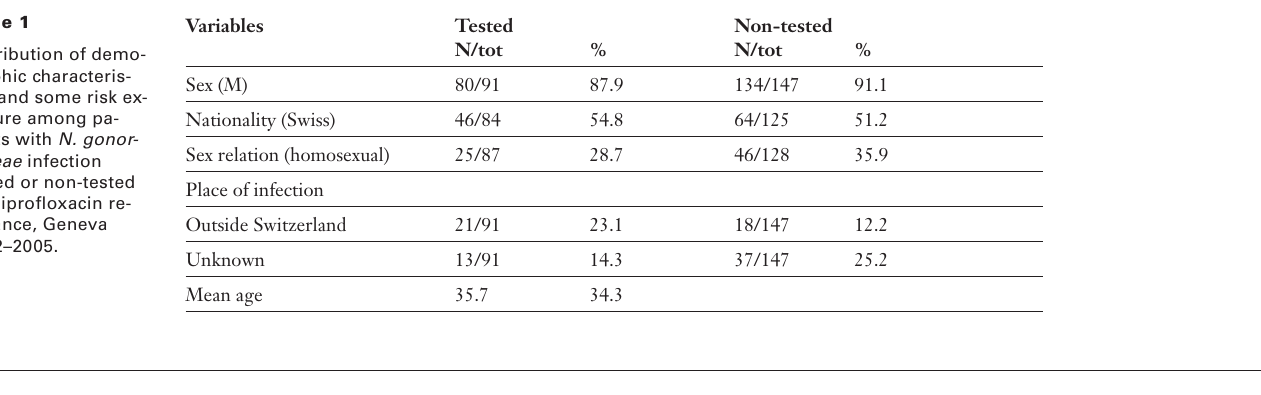
Table 2 Risk factors for ciprofloxacin-resis- tance among N. gon- orrhoeae isolates, Geneva